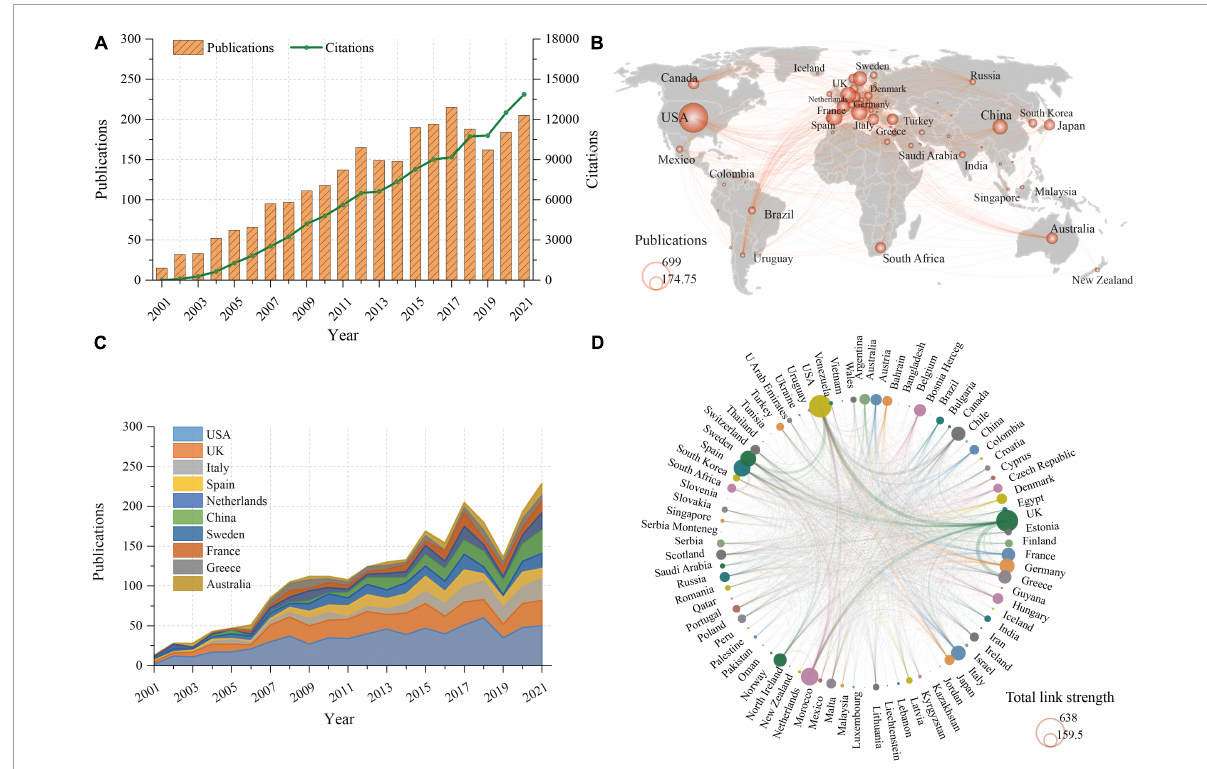
FIGURE2 (A) Trends in annual citations and publications about rheumatoid arthritis-related cardiovascular disease from 2001 to 2021. (B) World map showing the contribution of each country. (C) Trends in annual publication count in the top 10 productive countries. (D) Cooperation network among countries. The thickness of lines between two countries indicates the strength of cooperation.